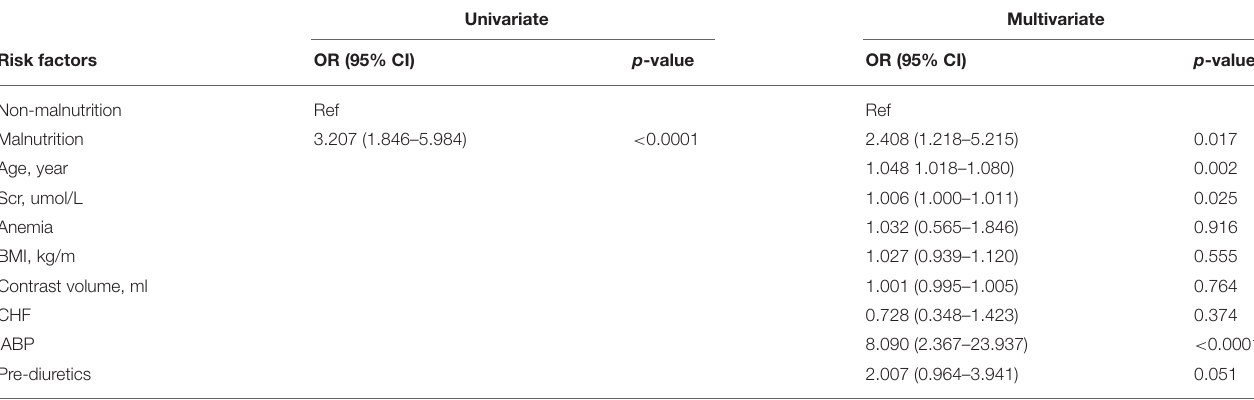
TABLE 2 | Risk of contrast-associated acute kidney injury (CA-AKI)-associated nutritional state in patients undergoing percutaneous coronary intervention (PCI) (Cut-off value based on a traditional threshold). Univariate